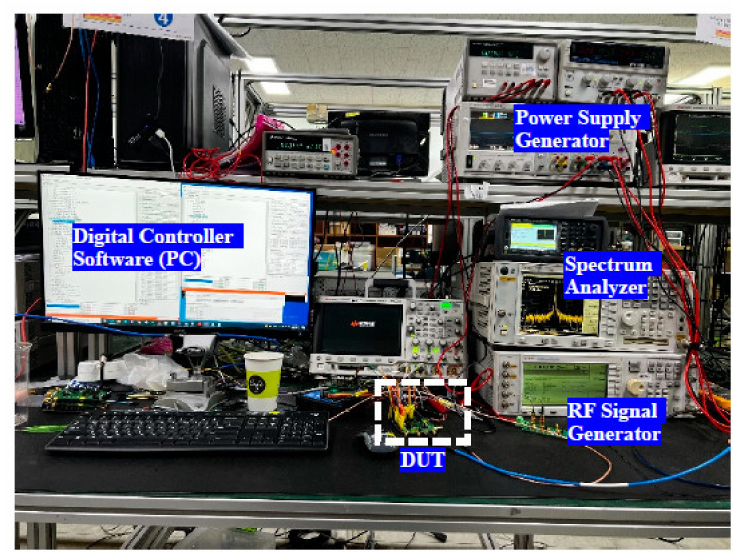
Figure 13. Measurement setup for the DPA (DUT) test.